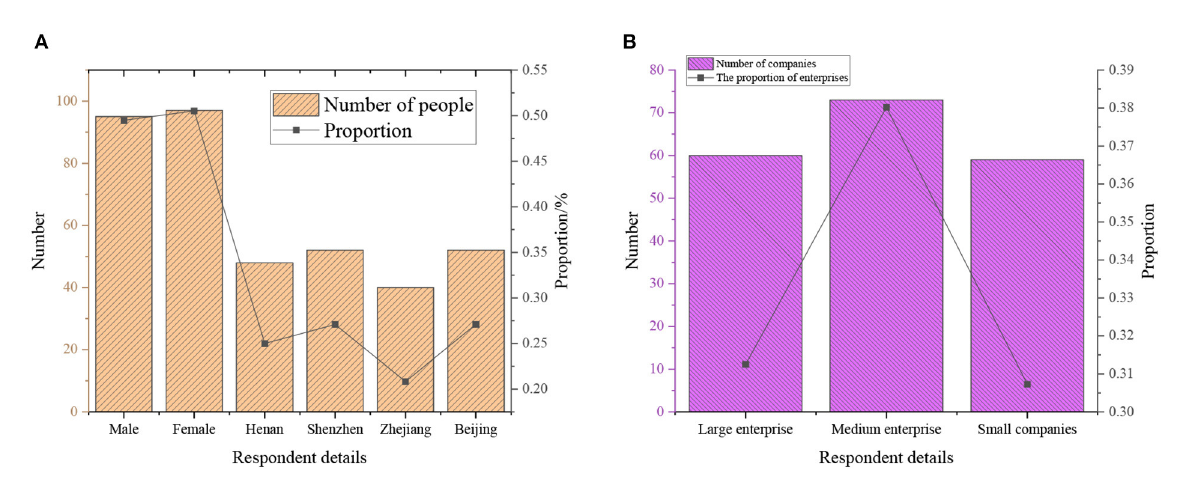
FIGURE5 Detailed distribution map of respondents. (A) The number and proportion of gender and city; (B) The number and proportion of business